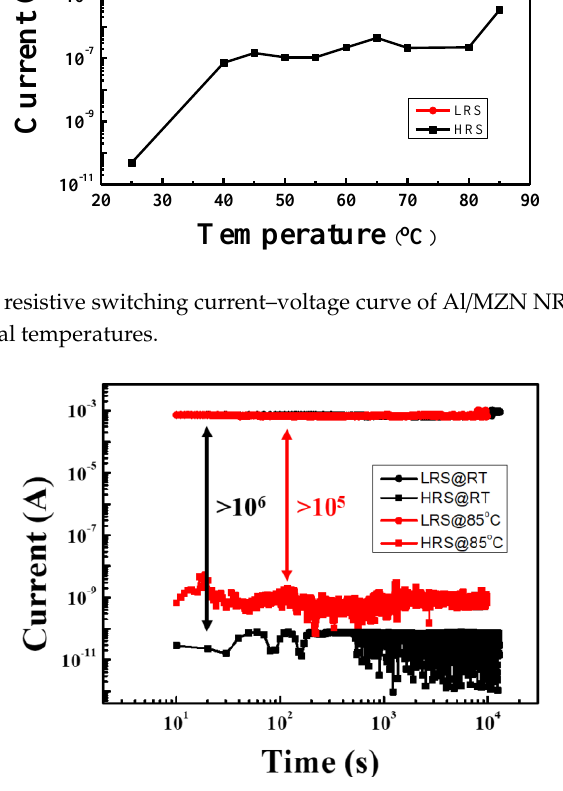
Figure 12. The typical resistive switching current – voltage curve of Al/MZN NR/ITO RRAM device at different environmental temperatures.